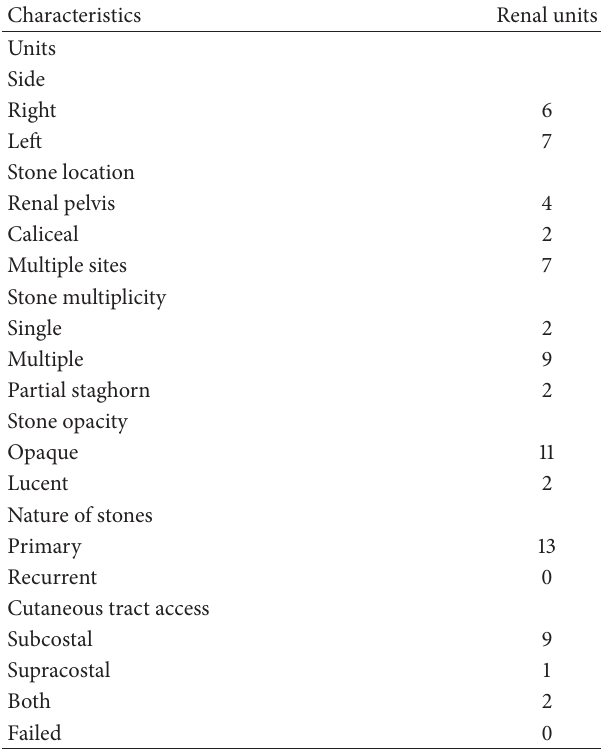
Table 3: Stone characteristics and puncture locations.